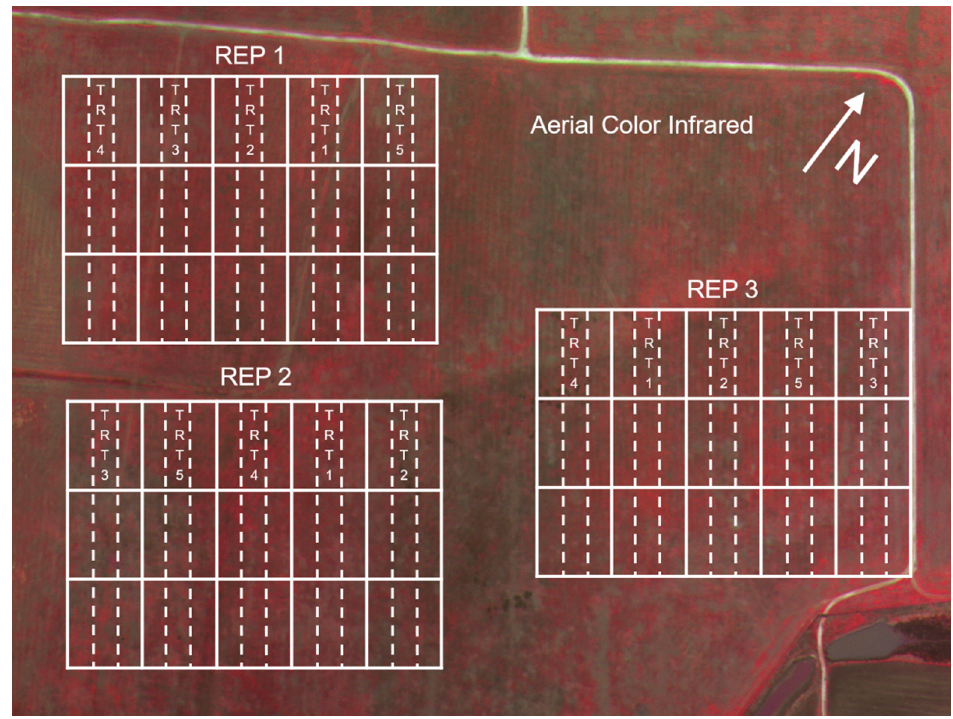
Figure 1. Plot layout of the study area. Note the study area was near a slough on the north side of the study plot.